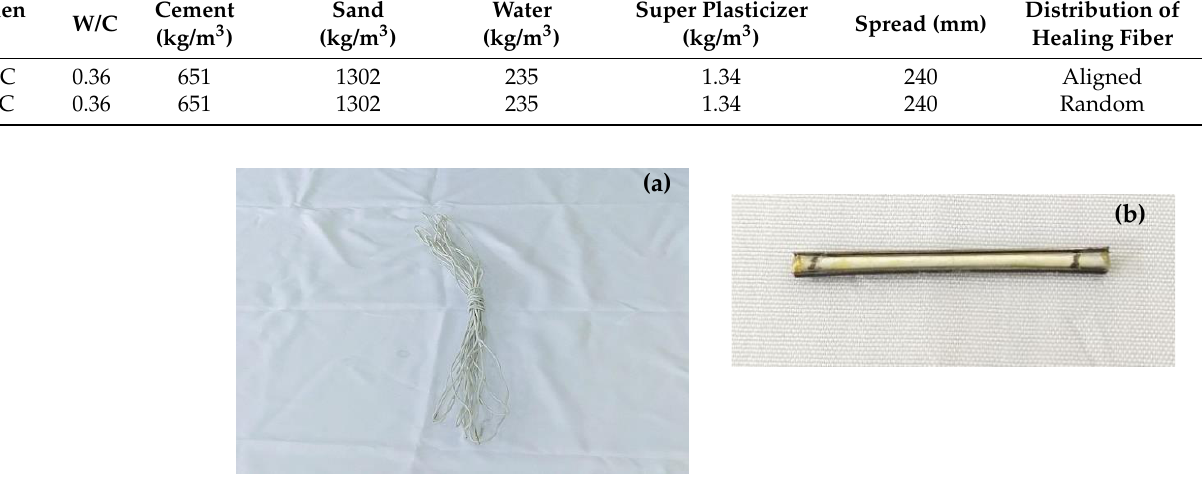
Figure 1. Containers preparation: ( a ) healing fiber, ( b ) hybrid fiber.